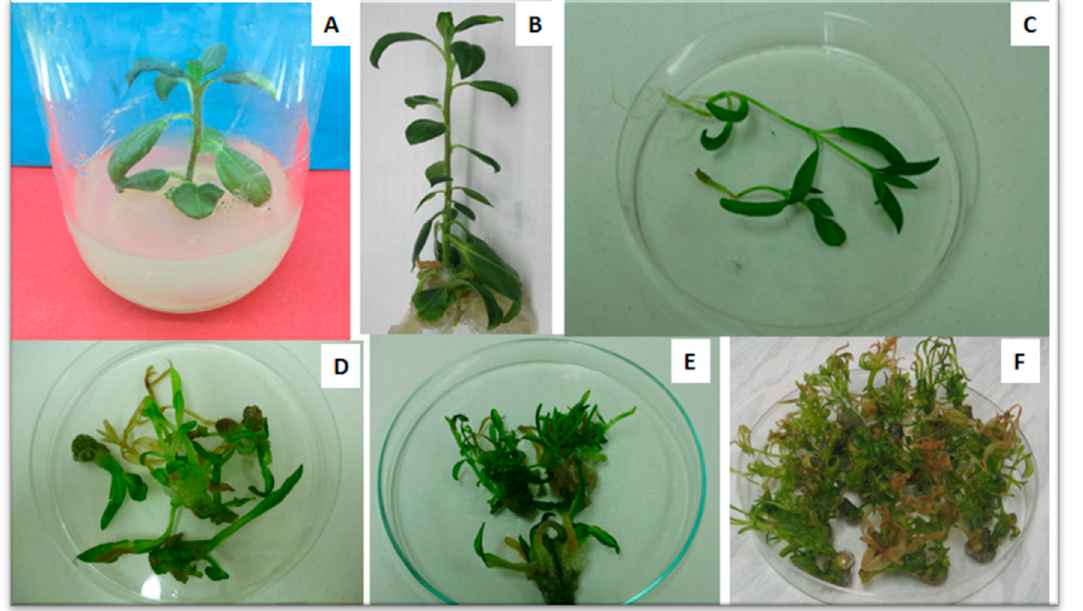
Figure 6. Effect of hyperhydricity on in vitro shoot proliferation of Jerusalem artichoke plant ( Helianthus tuberosus L.). Photos ( A – C ) = normal in vitro plantlets, whereas photos ( D – F ) = hyperhydrated in vitro plantlets.